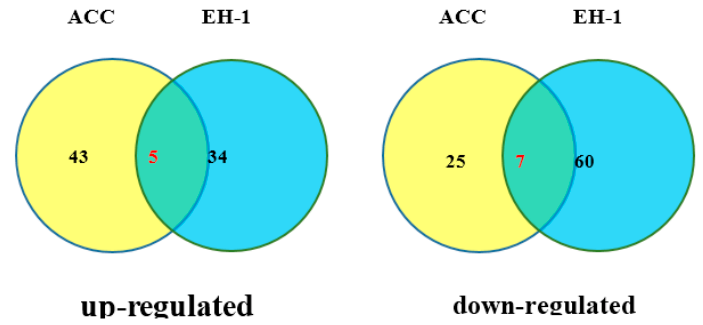
Figure 3. Venn diagram of genes regulated by ACC and EH-1 . The expression level of genes in Arabidopsis seedlings were identified by RNA sequencing (RNA-Seq) analysis. Both up-regulated and down-regulated genes with above 20 fold were estimated from Arabidopsis seedlings grown in the plate containing ACC or EH-1 using no-chemical treated Arabidopsis seedlings as a control.